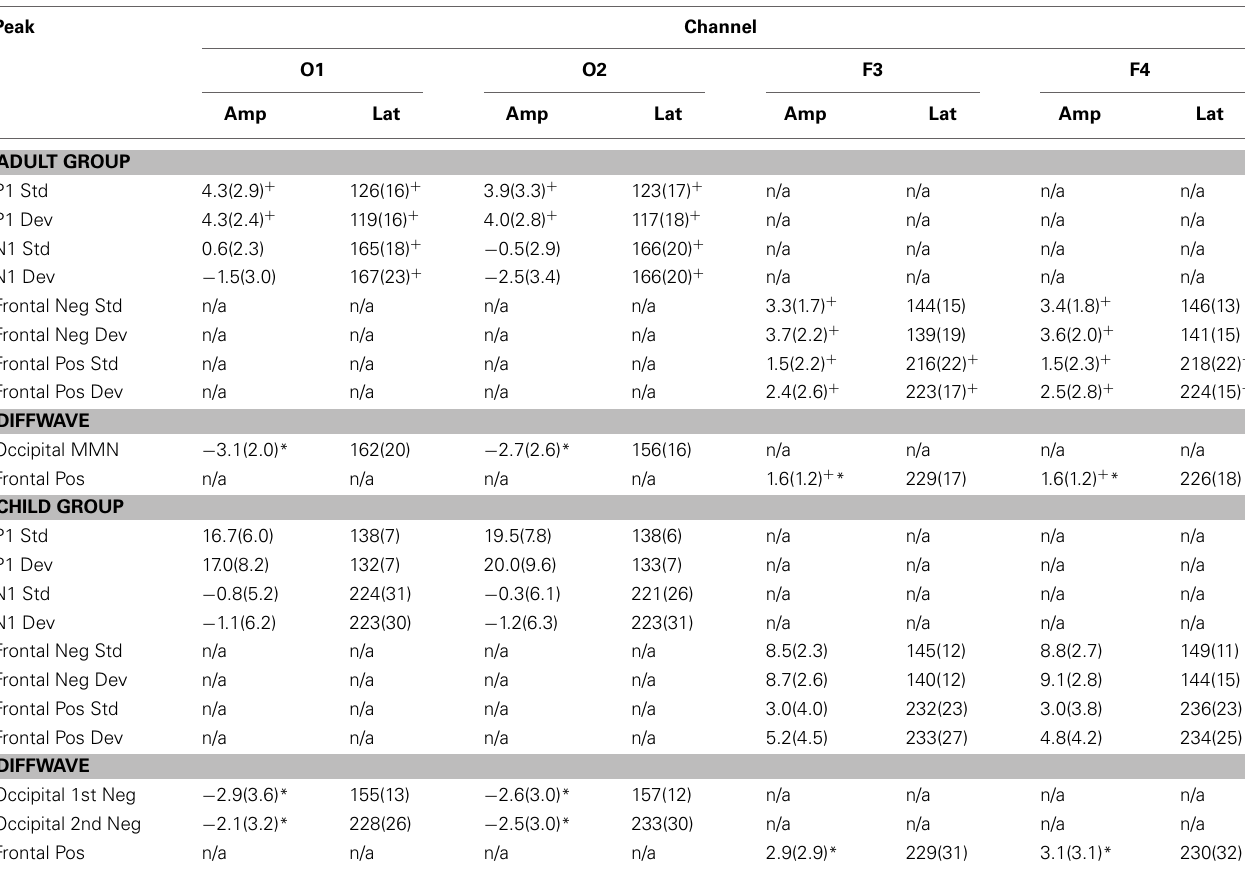
Table A1 | Peak amplitude values and latencies for ERPs and difference waves for electrode positions O1, O2, F3, and